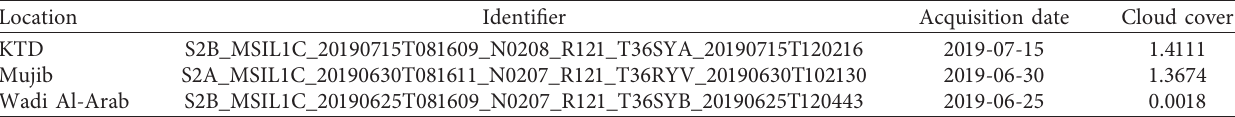
Table 4: Sentinel 2 images used for algorithm